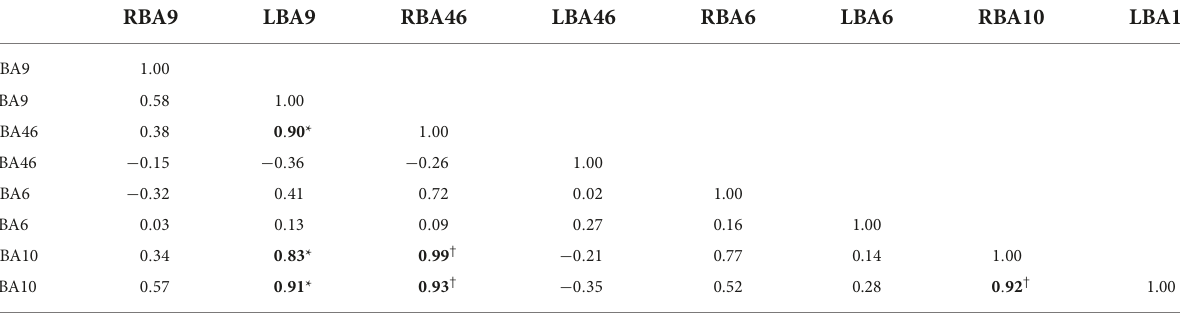
TABLE 7 HbO-based ROIs connectivity analysis—the intervention group.